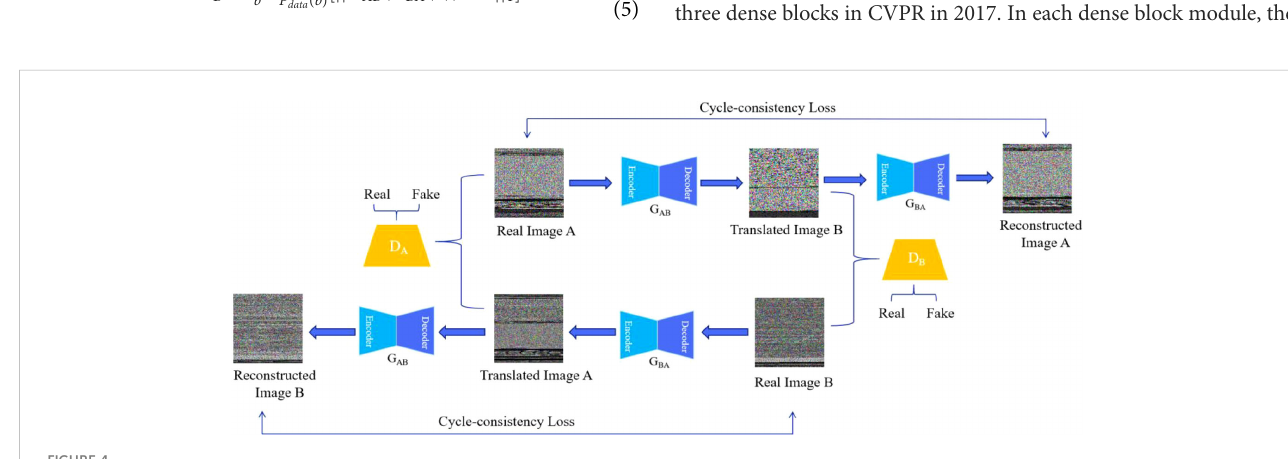
FIGURE 4 Data augmentation